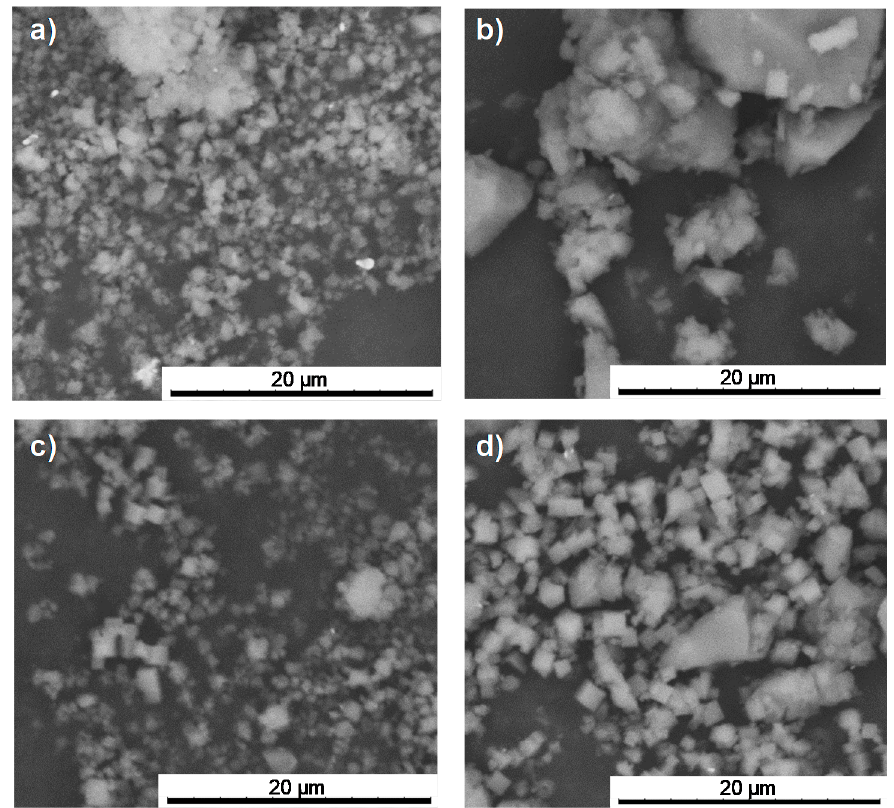
Figure 3. SEM images of the prsitine ( a ) MIL-100 and ( c ) MIL-127; and the corresponding drugs-loaded